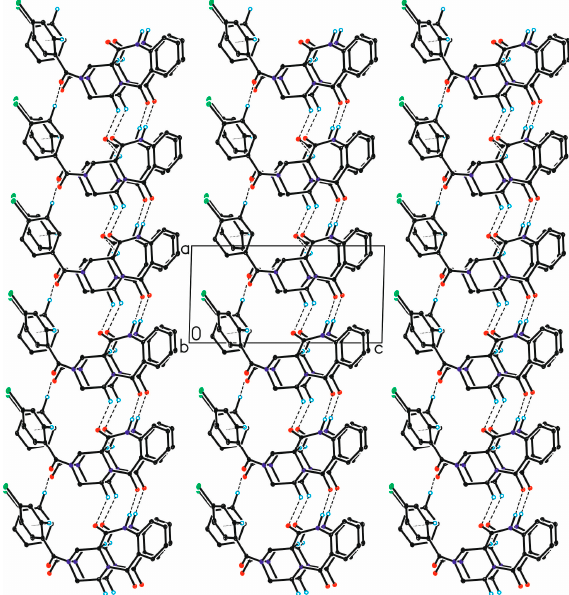
Figure 4. The arrangement of molecules in the crystal of 4 , viewed along b -direction. The H-atoms not involved in the intermolecular interactions have been omitted for clarity. Hydrogen bonds are represented by the dashed lines, while the C–H··· π contacts by dotted lines.